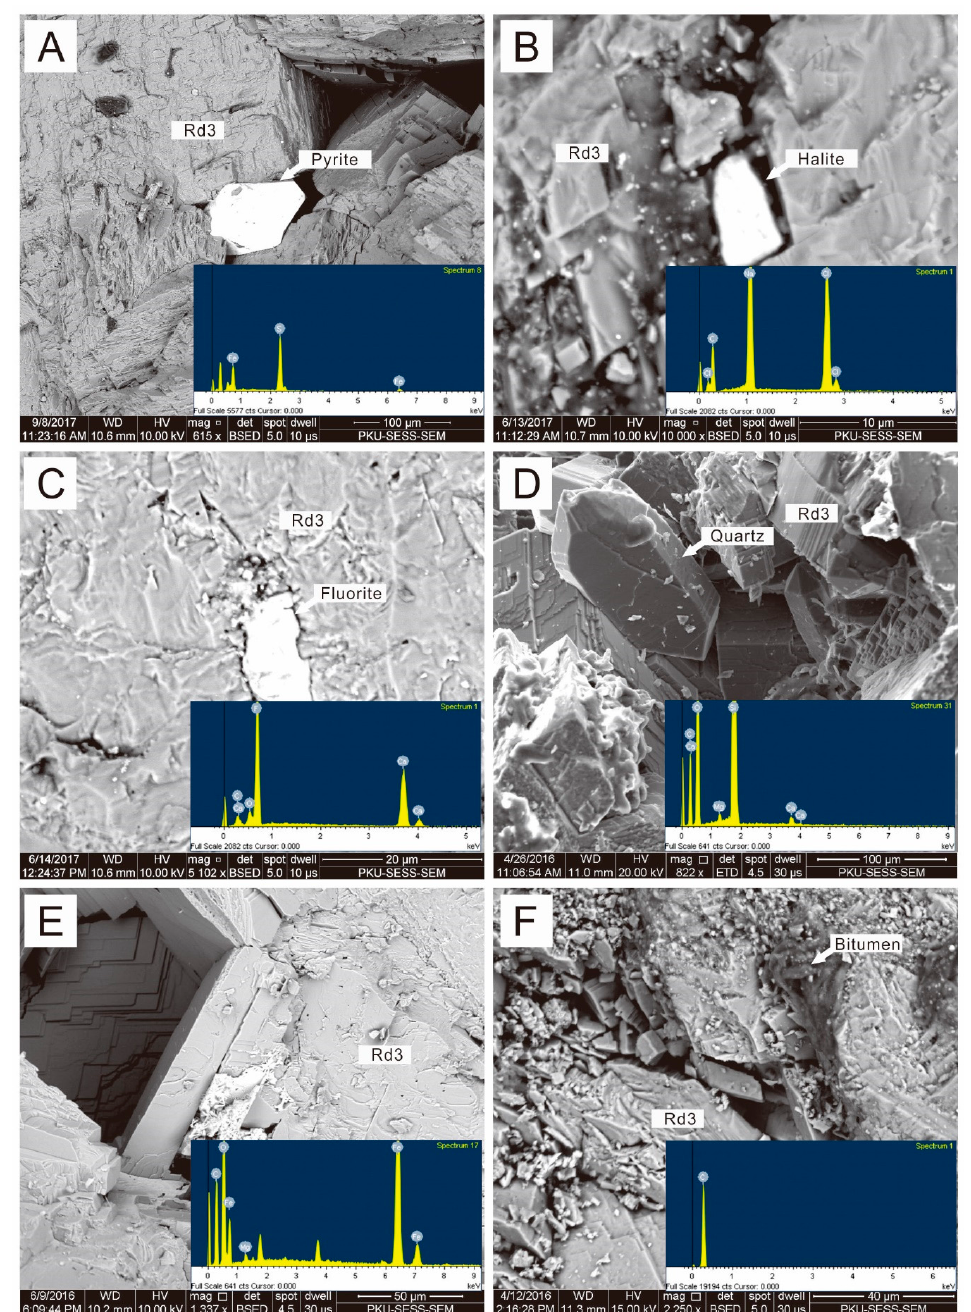
Figure 8. SEM images and energy-dispersive X-ray spectroscopy (EDS) analysis images of intercrystalline minerals in Rd3 and Cd dolomites. ( A ) Pyrite crystals within intercrystalline pores (4966 m; Well Hanshen1; P 2 q ); ( B ) halite crystals within intercrystalline pores (4971.6 m; Well Hanshen1; P 2 q ); ( C ) fluorite crystals within intercrystalline pores (4992 m; Well Hanshen1; P 2 q ); ( D ) quartz crystals within intercrystalline pores (Xinjigu; P 2 q ); ( E ) siderite crystals within intercrystalline pores (Xinjigu; P 2 q ); ( F ) bitumen crystals within intercrystalline pores (Zhangcun; P 2 q ).